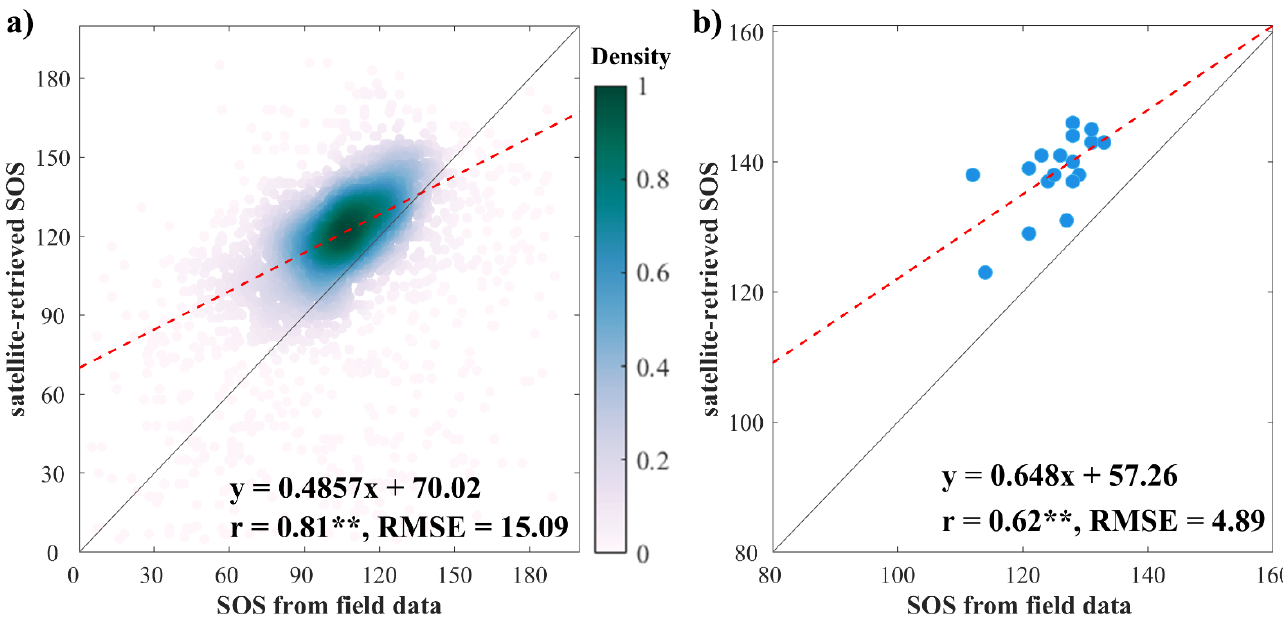
Figure 6. Comparison of satellite-derived dates of SOS with in-situ data, where ( a ) is USA-NPN data, and b ) is Harvard Forest data. The red dashed lines denote regression lines. ** denotes p < 0.01.